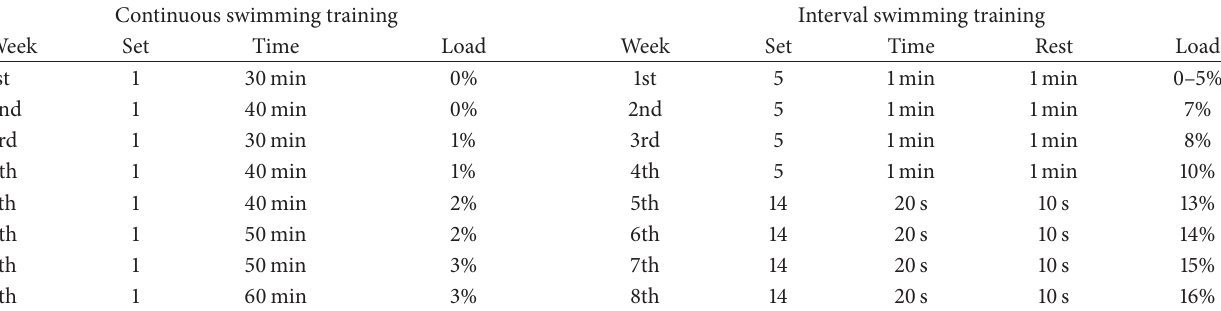
Table 1: Continuous and interval swimming training protocols.